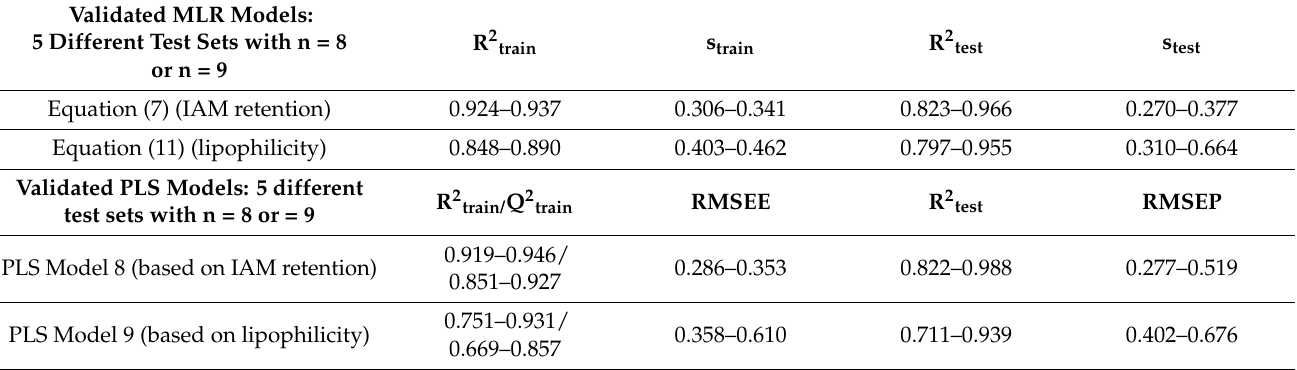
Table 3. Ranges of statistical values for the training and external test sets for logK b validated